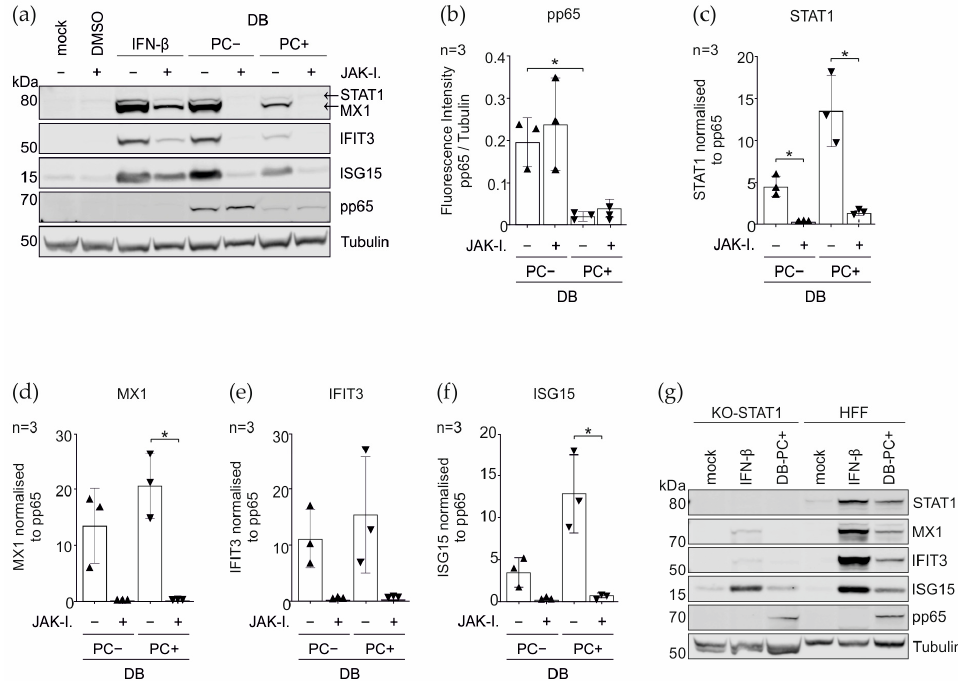
Figure 7. Immunoblot analysis on the relevance of the IFN-signaling pathway for the DB-mediated IRG induction. HFFs were pretreated with either JAK inhibitor I (20 µ M/mL) or DMSO. One hour later, the cells were either left untreated (mock), treated with IFN- β (100 U/mL), or treated with 20 µ g of the UV inactivated DBs of TR-BAC (PC − ) or TR- ∆ GFP (PC+). Each sample was further co-treated with JAK inhibitor I for 24 h. ( a ) Representative immunoblot analysis of the STAT1 expression and the downstream IRG protein levels of MX1, IFIT3, and ISG15 in the HFFs upon the JAK inhibitor I treatment, compared to the untreated control cells. IFN- β treatment was used to control for the effects of the inhibitor on the JAK-STAT signaling cascade. Tubulin was used as a protein loading control. Pp65 was used as a DB internalization control. ( b – f ) Quantification of the reduction of the IRG protein expression, by calculating the ratio of the fluorescence intensities relative to tubulin and the normalization to pp65. Comparisons between the groups were calculated using an unpaired t -test with Welch ´ s correction. The values of three independent experiments were plotted. * p < 0.05. (cid:78) Pentameric complex negative Dense Bodies; (cid:72) Pentameric complex positive Dense Bodies. ( g ) IFN response in the STAT1 CRISPR/Cas9 knockout HFFs (KO_STAT1). Lysates of the mock-treated, IFN- β -treated (IFN- β , 100 U/mL), and TR- ∆ GFP-derived DB (20 µ g) treated HFFs were made and analyzed for expression of STAT1, MX1, IFIT3, and ISG15. Additionally, the detection of the tubulin expression was used as a loading control and viral phosphoprotein pp65 as a DB internalization